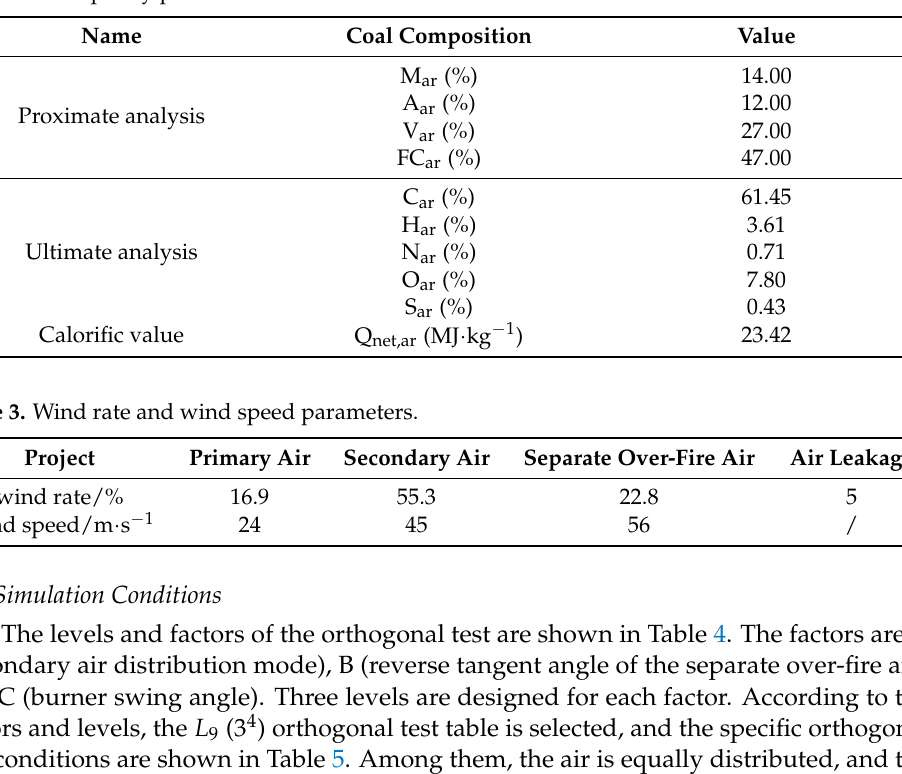
Table 2. Coal quality parameters.